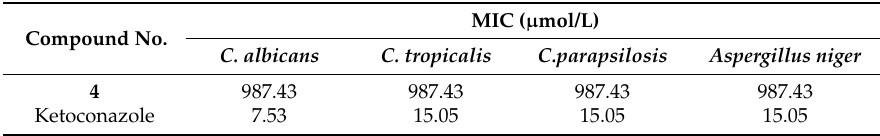
Table 6. Antifungal activity of compound 4 and ketoconazole against different Candida species and Aspergillus niger